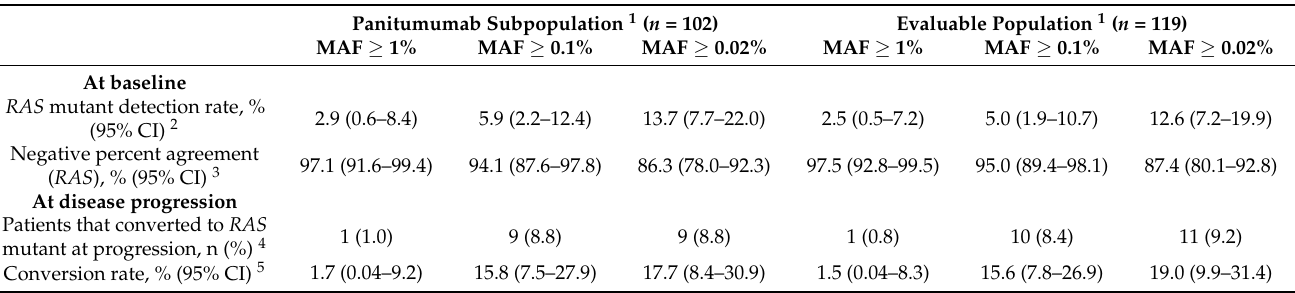
Table 2. Percentage of RAS mutations in liquid biopsies at baseline and conversion rate at disease progression according to MAF